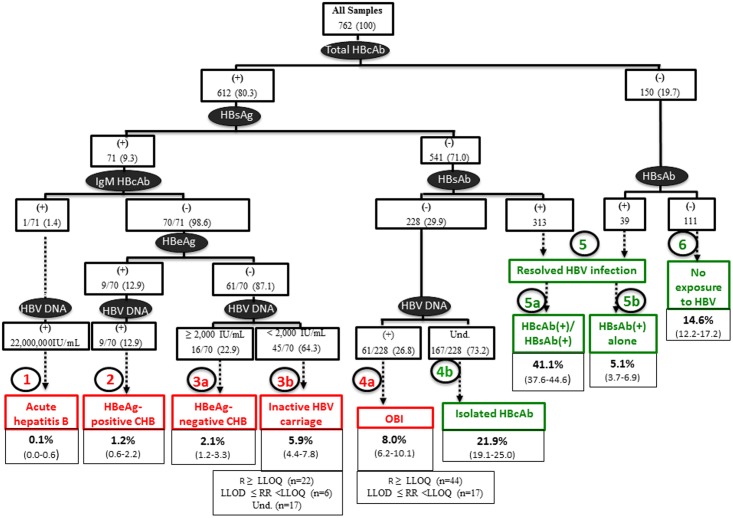
HBV patterns defined by serological results and serum HBV DNA levels.Infectious patterns are indicated in red boxes. Non-infectious patterns are indicated in green boxes. Overall prevalence rates are n (%) unless otherwise stated. Abbreviations: (+), positive; (-), negative; Und., undetectable; R, reactive; RR, repeatedly reactive; CHB, chronic hepatitis B; OBI, hepatitis B occult.